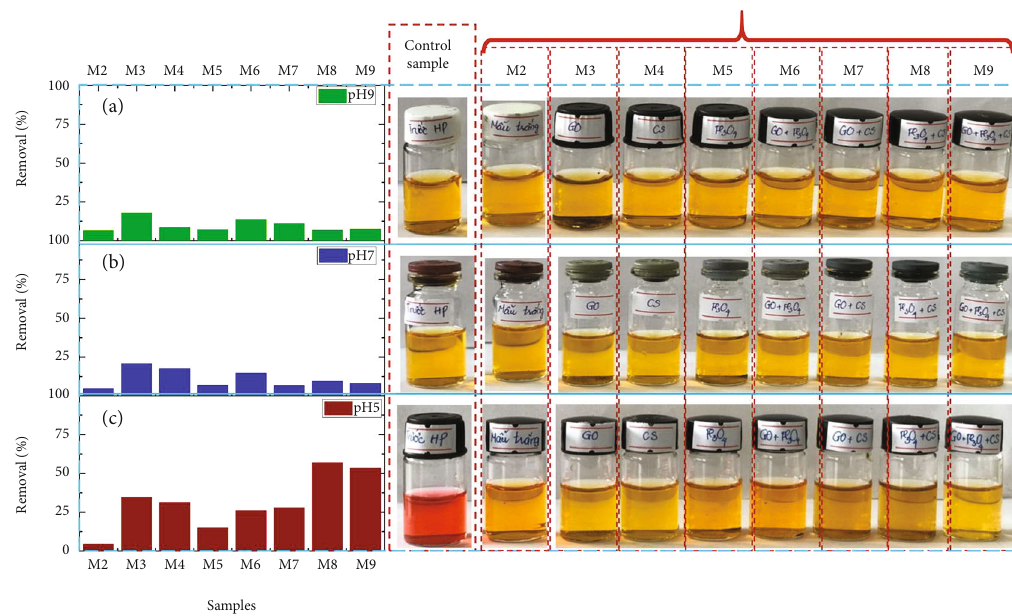
Figure 4: E ff ects of pH on MO adsorption onto the GFC/NWPF absorbent: (a) pH5, (b) pH 7, and (c) pH 9 (inserted images: corresponding color of MO solutions before and after the adsorption process).